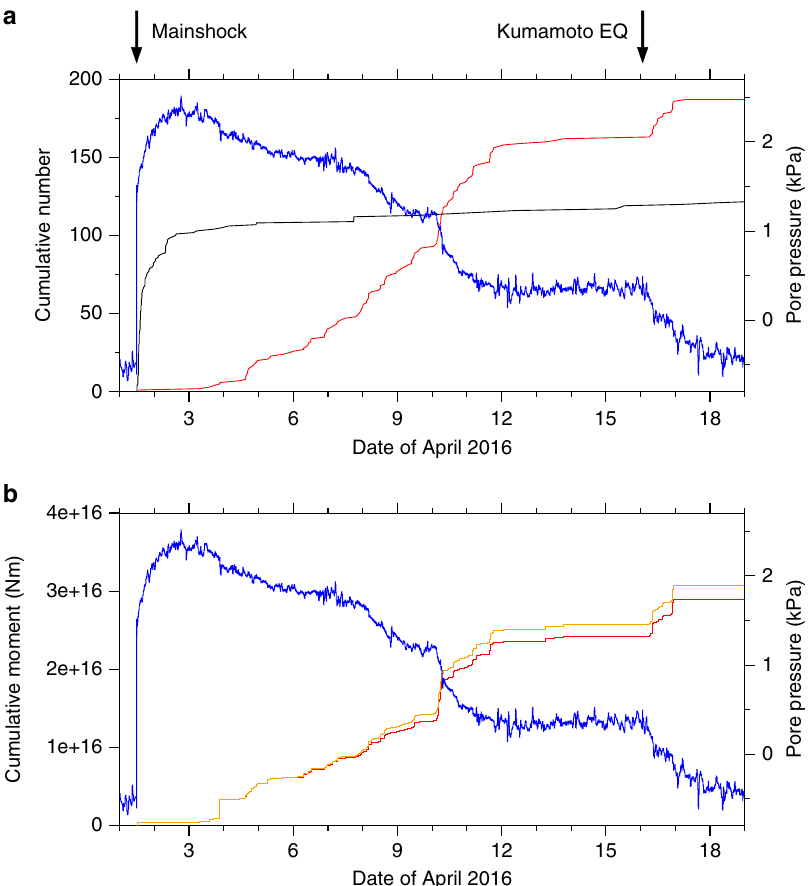
Fig. 4 Temporal evolution of seismic activities and borehole pore-pressure changes. a Cumulative numbers of sVLFEs larger than M w 3 (red), aftershocks of the off-Mie earthquake larger than magnitude 1 (black), and borehole pore-pressure changes 33 (blue). b Temporal evolution of cumulative moment due to sVLFEs larger than magnitude 3.0 (red) and all sVLFEs for which a CMT was determined